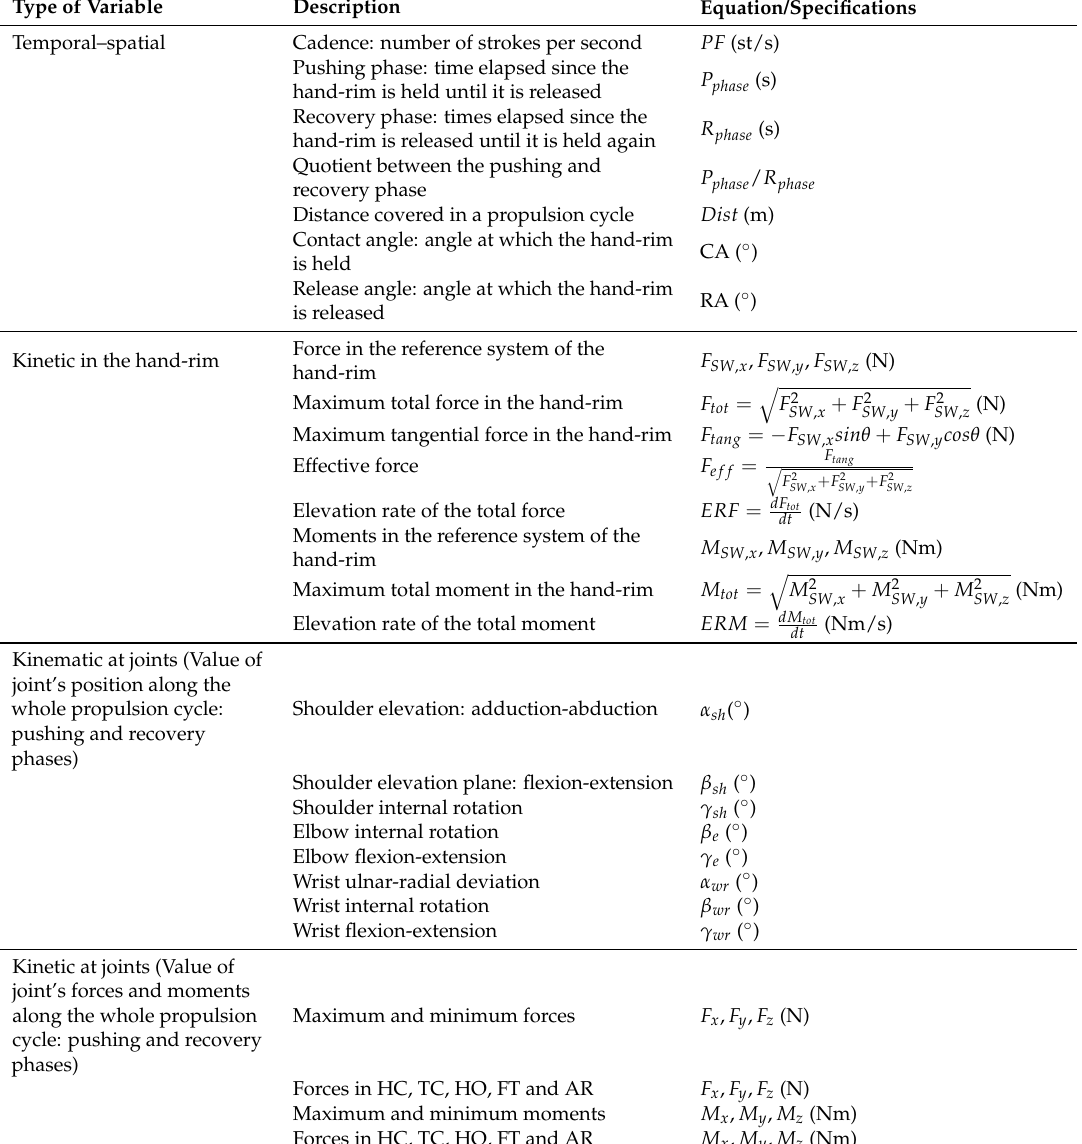
Table 5. All variables analyzed in the procedure proposed divided in